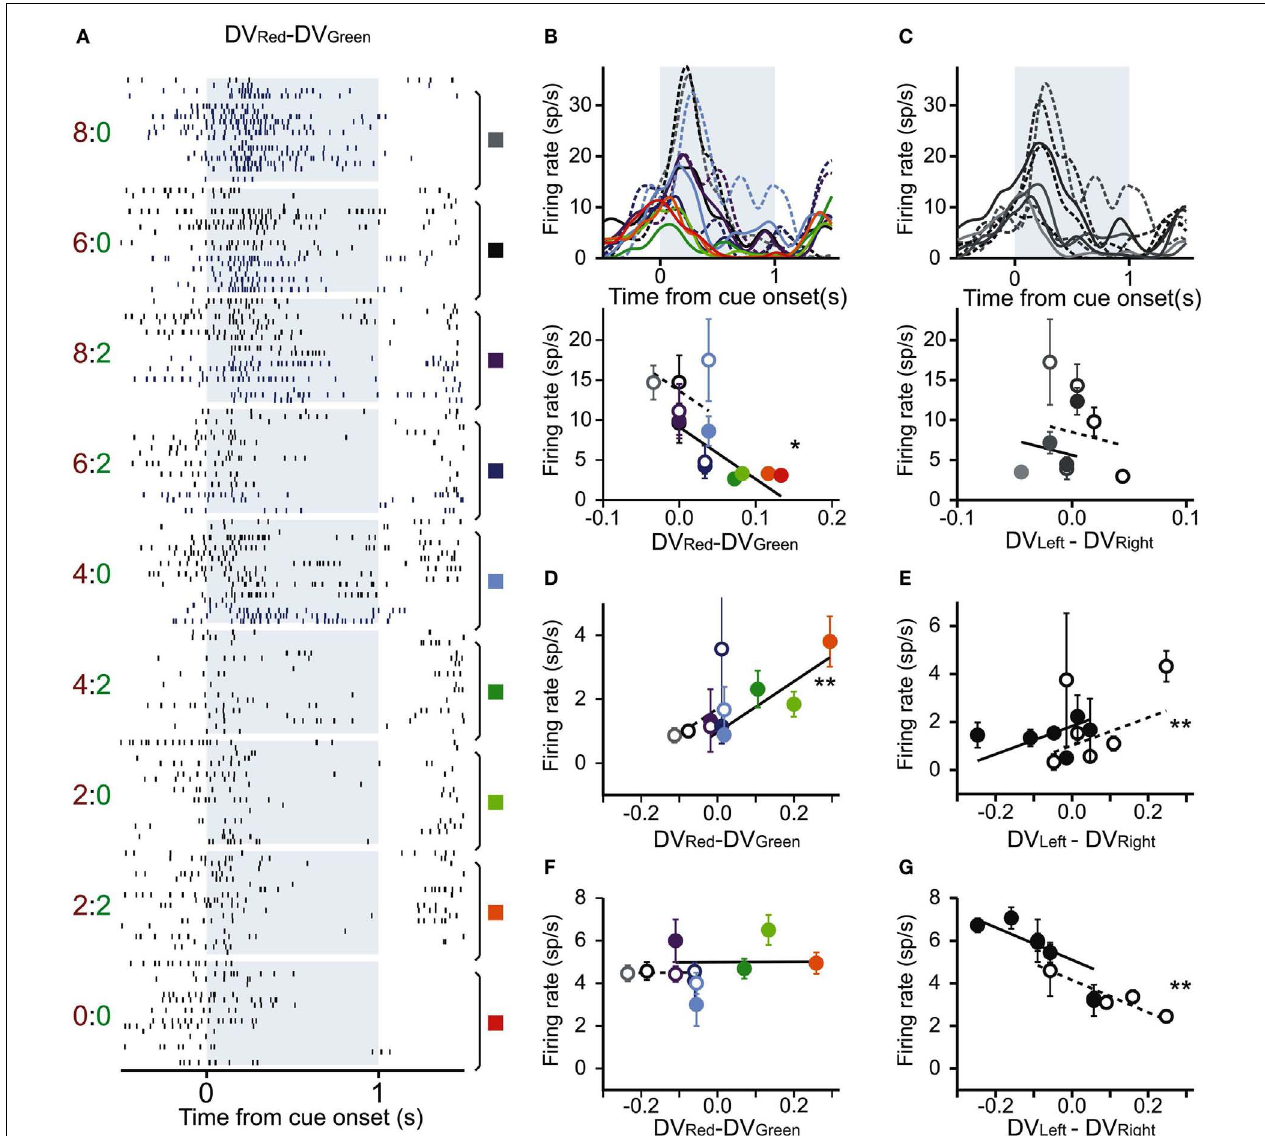
SDF and average firing rates during the trials in which the animal chose the small (large) reward. (C) SDF and average firing rates of the same neuron shown in (A) , estimated according to the difference in the DVs for left and right targets (represented in the grayscale). Dotted (solid) lines and empty (filled) symbols represent SDF and average firing rates during the trials in which the animal chose left (right) targets. (D–G) Average firing rates of two other DLPFC neurons. (D,E) Another neuron showing significant modulation in their activity related to the difference in the DVs for the large and small reward targets (D) and for the left and right targets (E) . (F,G) A third neuron showing significant activity only for the difference in DVs of left and right targets. (D,E–G) are in the same format as in the bottom panel of (B,C) . Error bars, SEM. * p < 0.01; ** p < 0.001 ( t -test for the corresponding regression